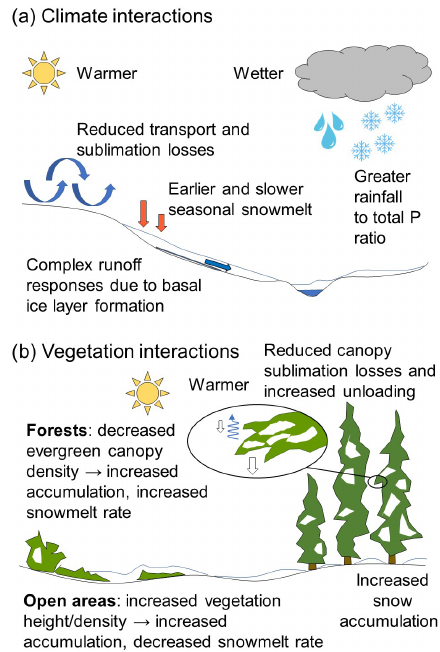
Figure 4. Conceptual schematic of expected snow change in the CCRN domain and similar cold regions. Warmer conditions lead to less snow, while wetter conditions can lead to more or less snow; warmer and wetter conditions can be partially compensatory. Other changes complicate the snow–climate interactions, and spatial pat- terns of vegetation change with respect to snow processes control snow